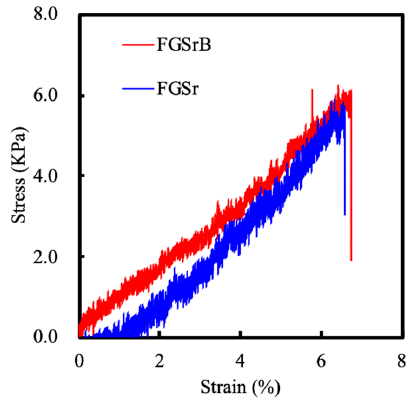
Figure 3. Tensile stress–strain curves of 3D-printed FGSr and FGSrB specimens.